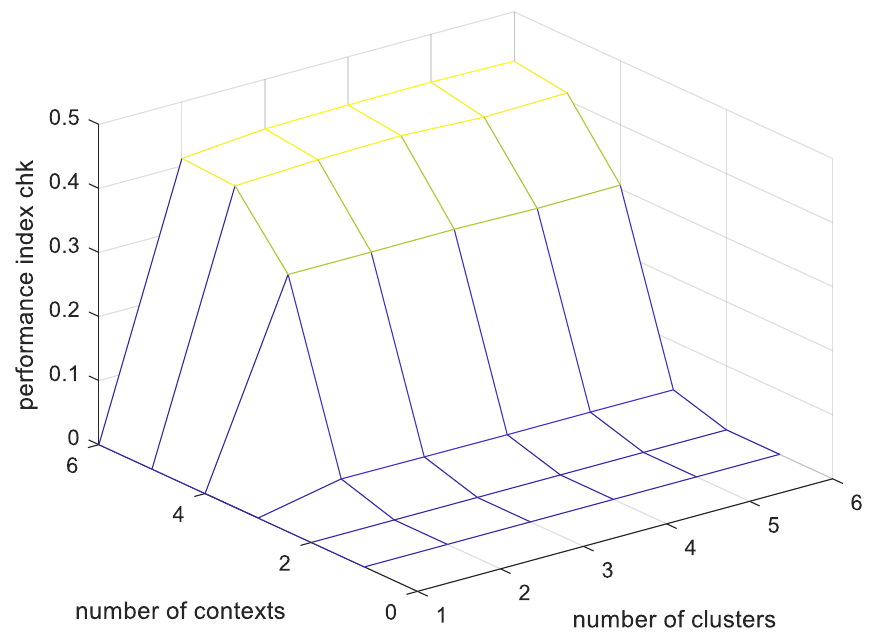
Figure 17. GM’s performance index for validation data (context equally generated, number of contexts = 6, number of clusters = 6).